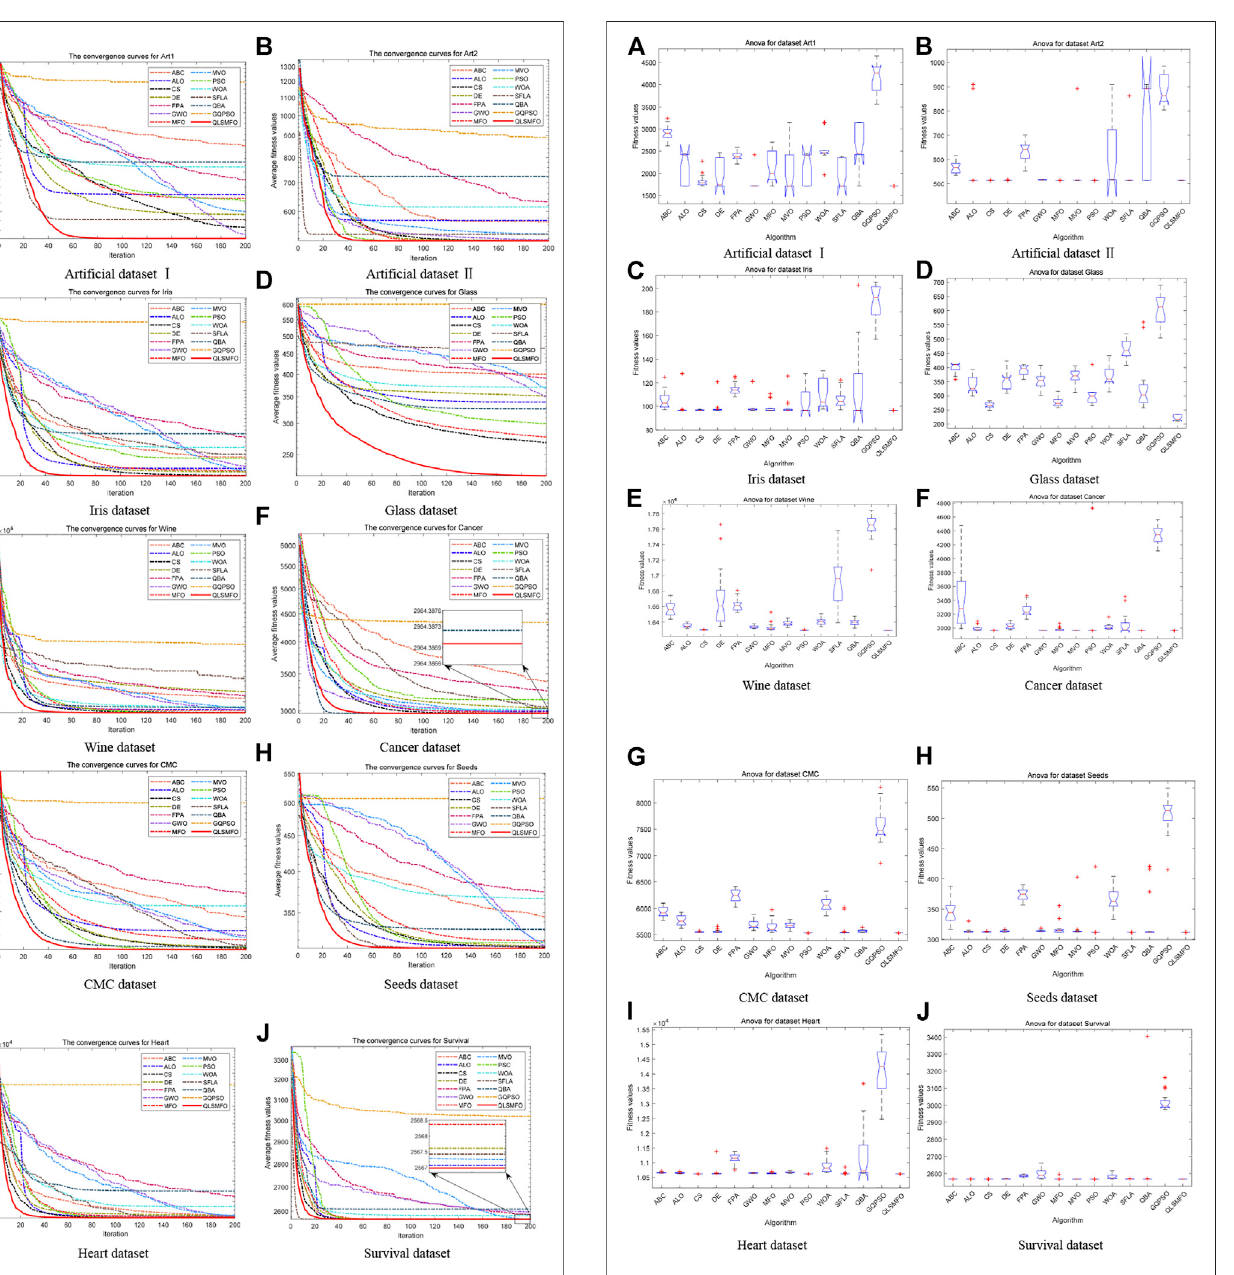
thirteen metaheuristics algorithms on ten test datasets. The data in the table are presented in the form of four decimal places, except for Std., which uses scienti fi c notation to retain two decimal places. In the table, Best indicates optimal fi tness value, Worst indicates the worst fi tness value, Mean indicates average fi tness value, and Std. indicates standard deviation. The four indicators are the statistics obtained by each